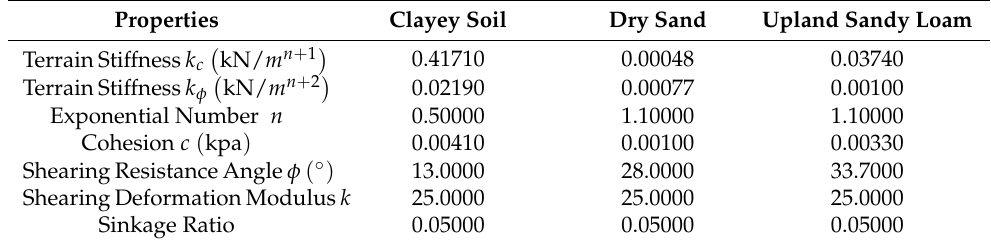
Table 1. Physical property of various soils [21,22].